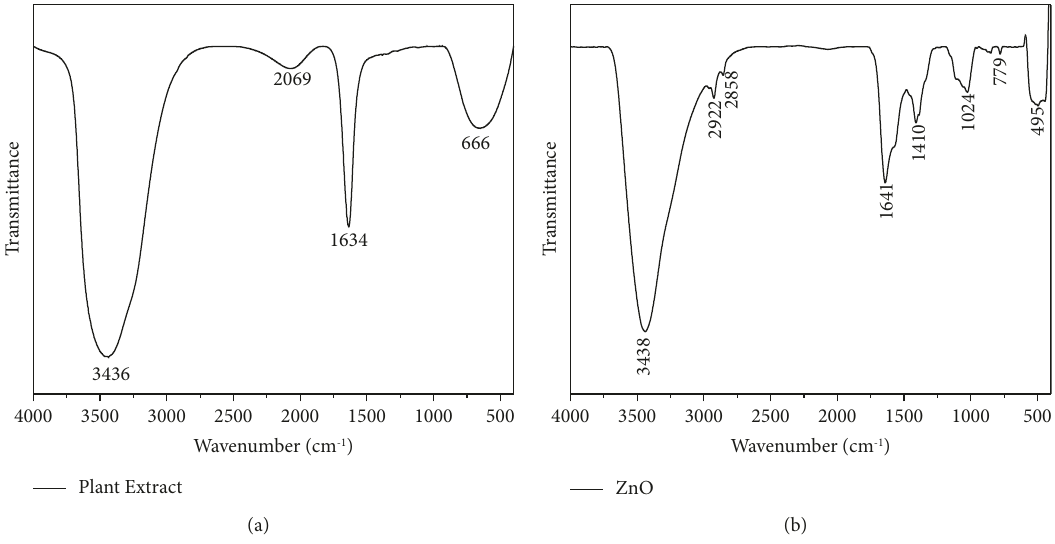
Figure 6: (a) FTIR spectrum of Solanum procumbens extract. (b) FTIR spectrum of SP-ZnONPs.